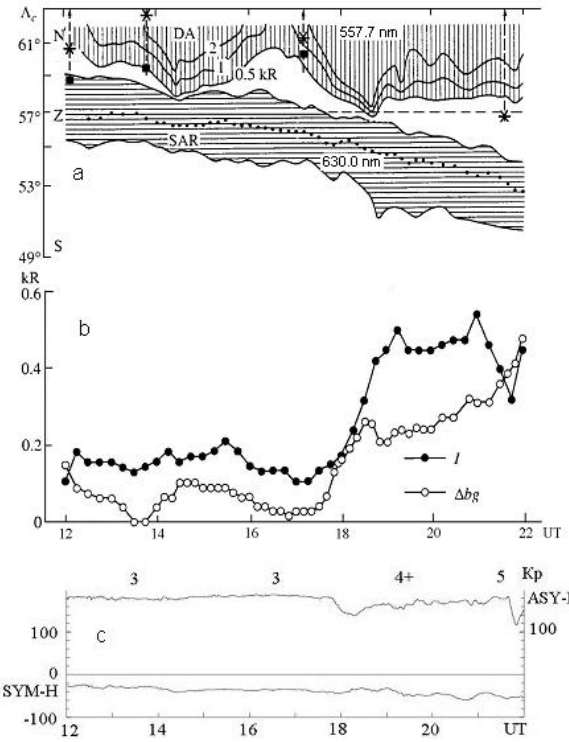
Figure 36. Modified figure from Ievenko and Alexeev (2004): (a) variation of the diffuse aurora (DA) position with 557.7nm emissions and the SAR arcs (the vertical lines indicate the over- flights of the DMSP satellites F9 and F8); (b) intensity variations of the SAR arcs (full dots) and the background luminosity (open cir- cles); (c) ASY-H and SYM-H indices together with the Kp values written on top